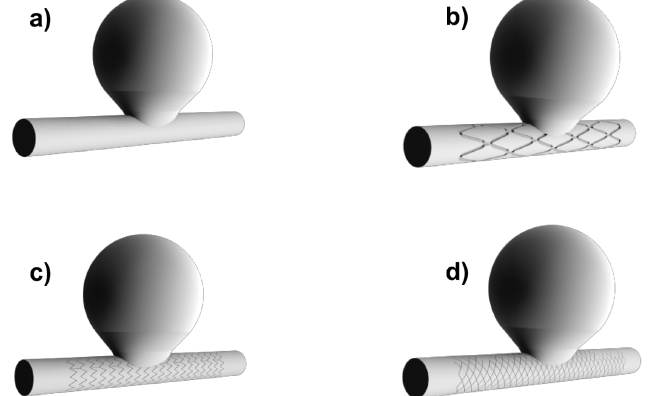
Figure 1. Idealized models of the aneurysmal cerebral artery: ( a ) control case, ( b ) STENT BS, ( c ) STENT 1, ( d ) STENT 2. The aneurysm and artery diameters are 19 mm and 4.75 mm, respectively. The width of the aneurysm neck is 10.7 mm and the aspect ratio (i.e., the maximum height of the dome over the aneurysm width) is